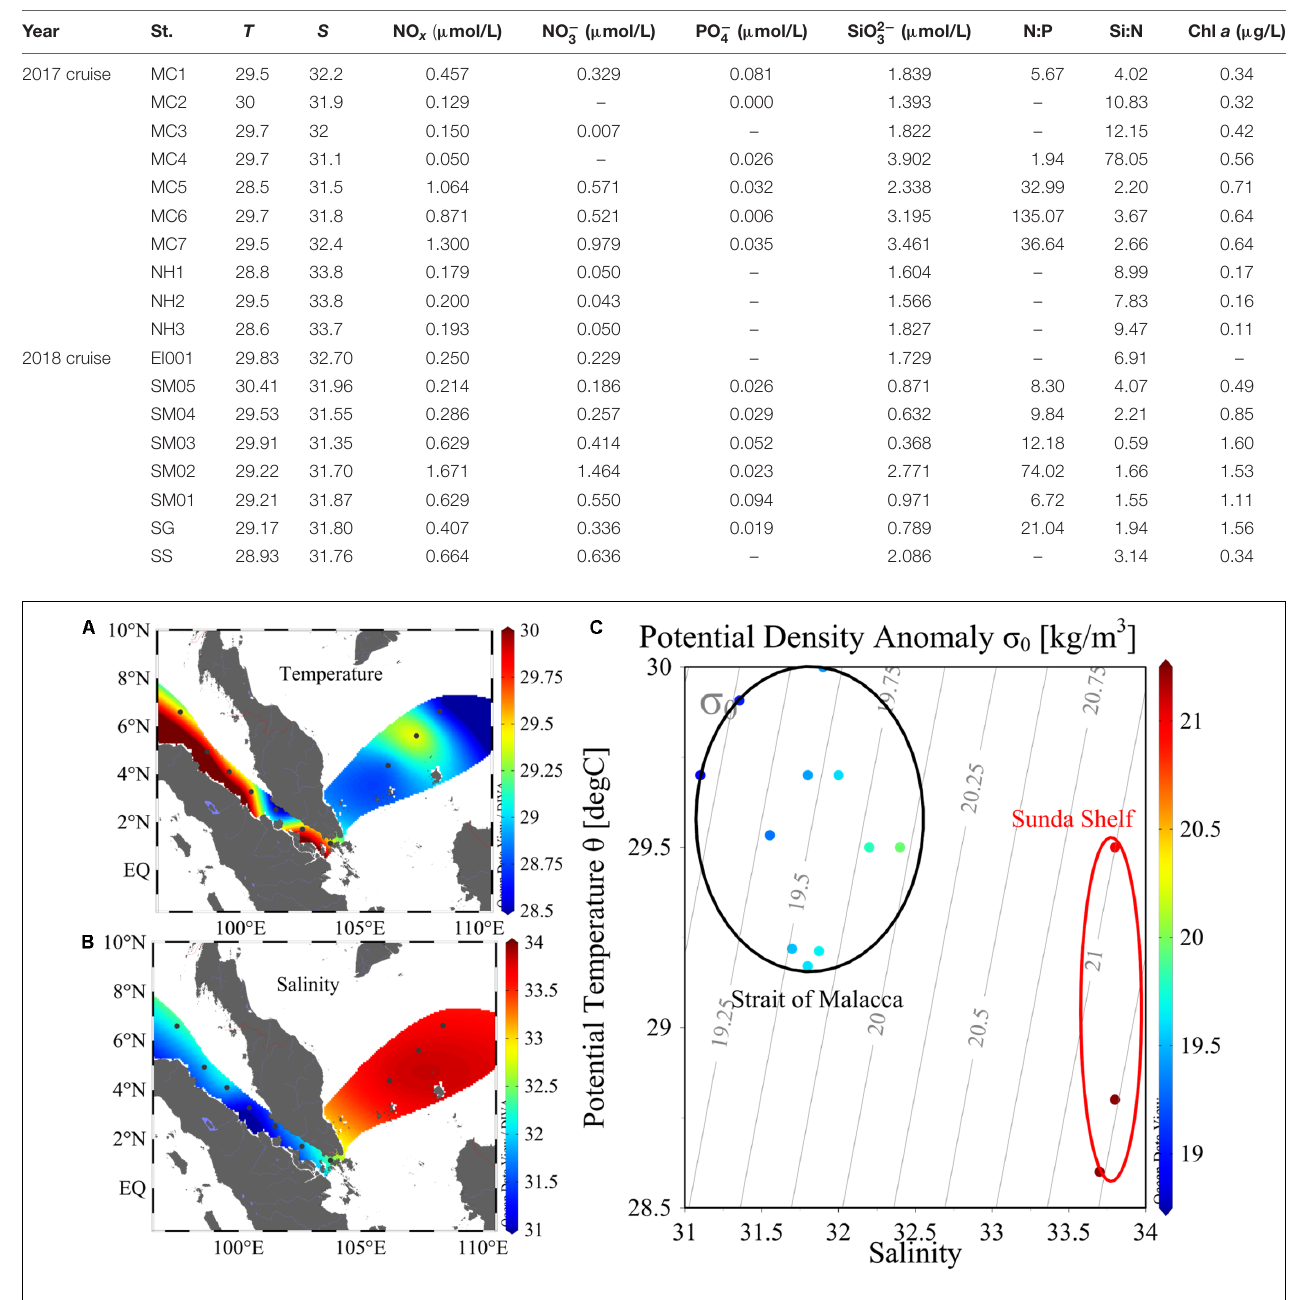
FIGURE 2 | Horizontal distribution of temperature (A) , salinity (B) , and T-S diagram (C) in 2017 cruise. Data points within the black triangle characterized water in the Strait of Malacca, and data points within the red ellipse characterized water in the Sunda Shelf.